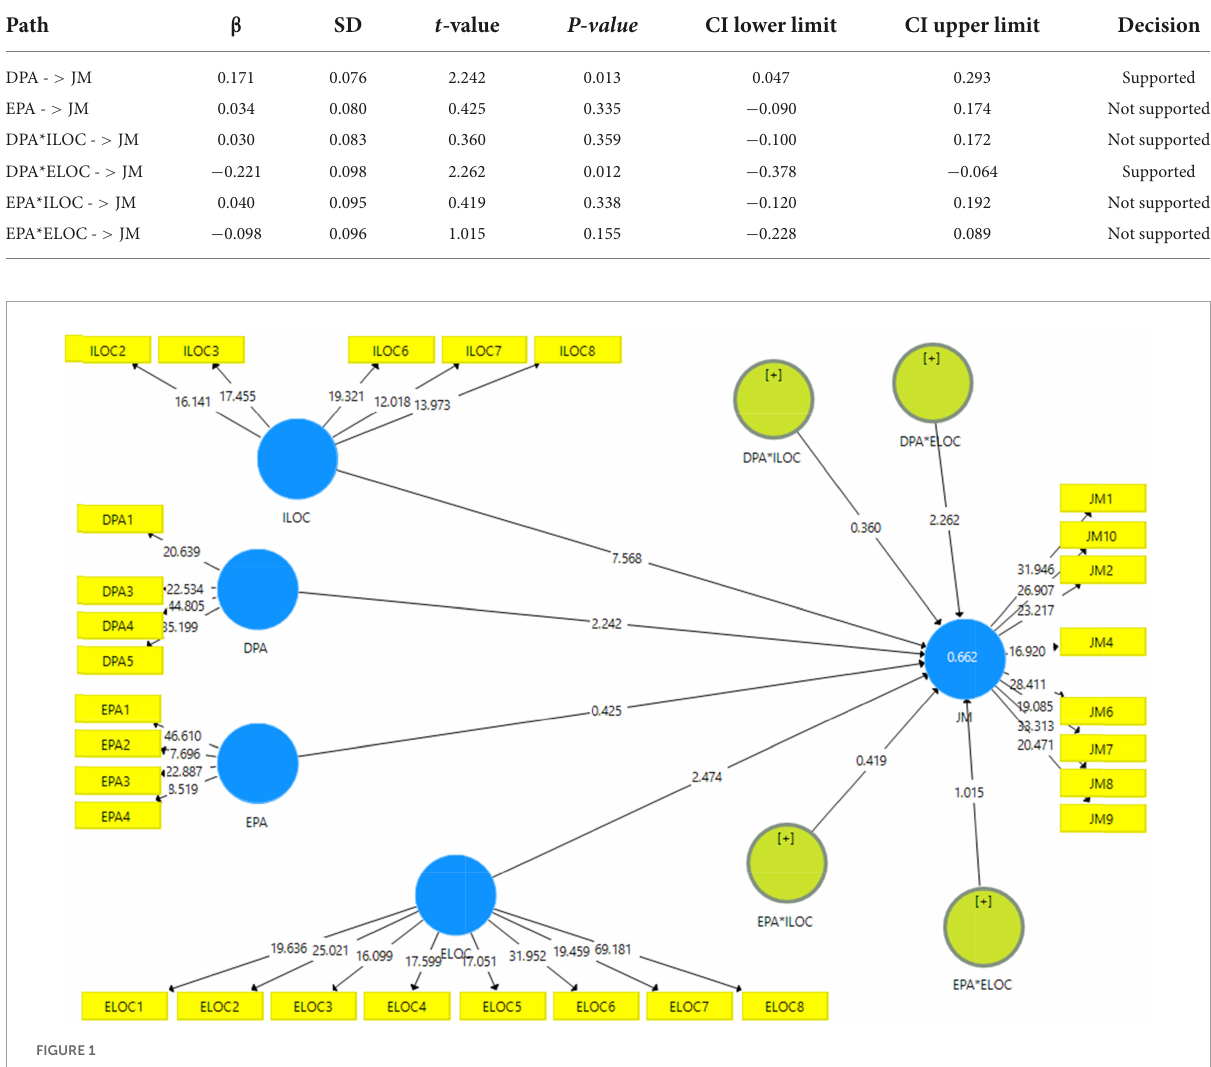
FIGURE1 Structural model